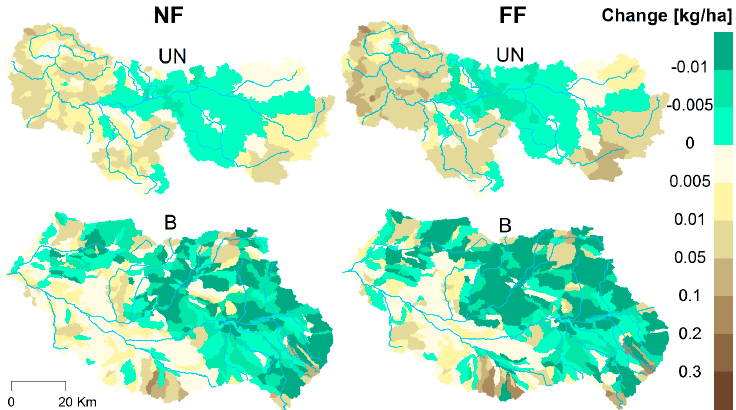
Figure 13. Projected change in TP losses (TP transported by all types of pathways form sub-basins to streams) in the Upper Narew and Barycz catchments in the near and far future according to the ensemble median.